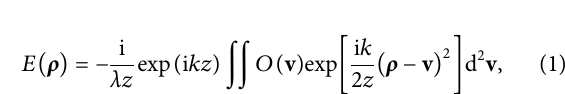
Frontiers in Physics |